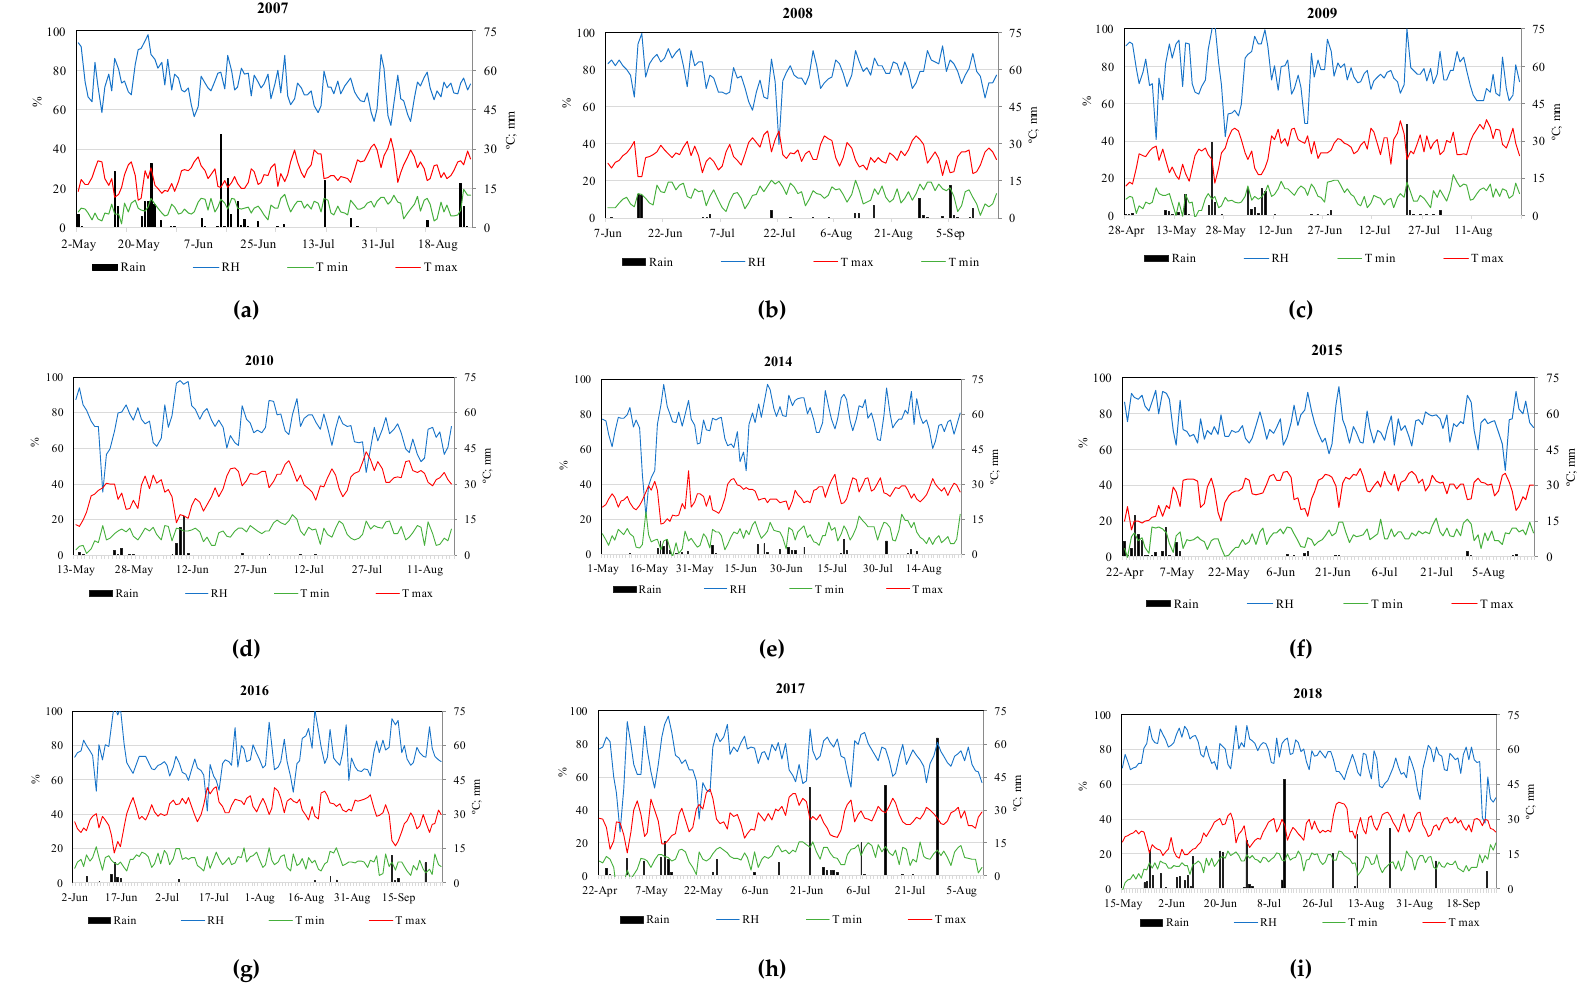
Figure 2. Daily data of the meteorological conditions recorded by potato growing season. Each subfigure ( a , b , c , d , e , f , g , h , and i ) includes the mean, minimum and maximum temperature, mean relative humidity and accumulated rain recorded in each crop cycle studied.